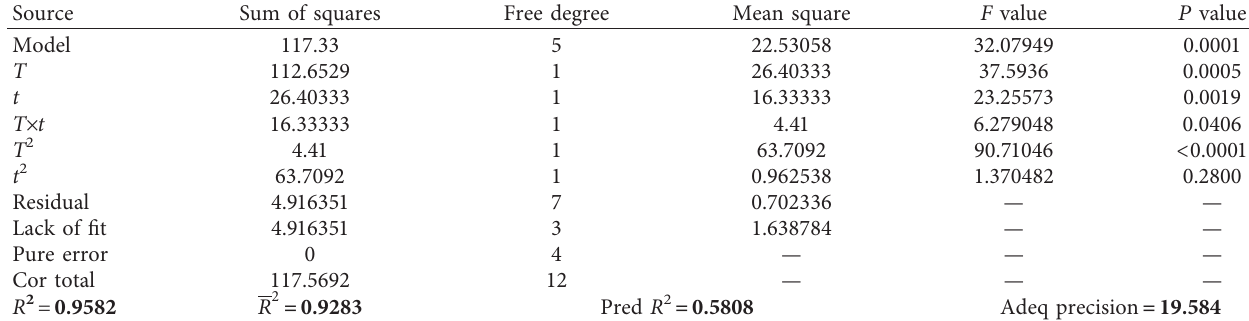
Table 5: Analysis of variance (ANOVA) for the quenching